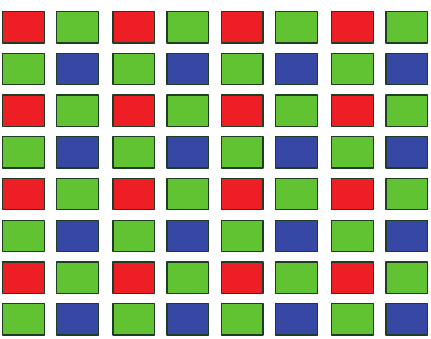
Figure 1: Bayer pattern color matrix with red-green-red-green phase in the first